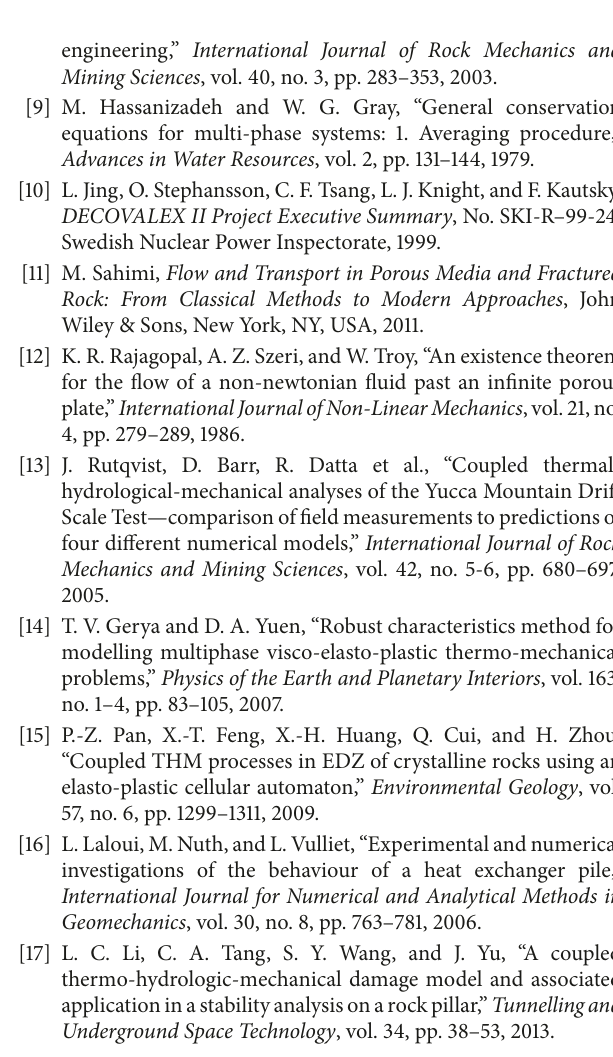
Figure 11: Effects of temperature on the relative